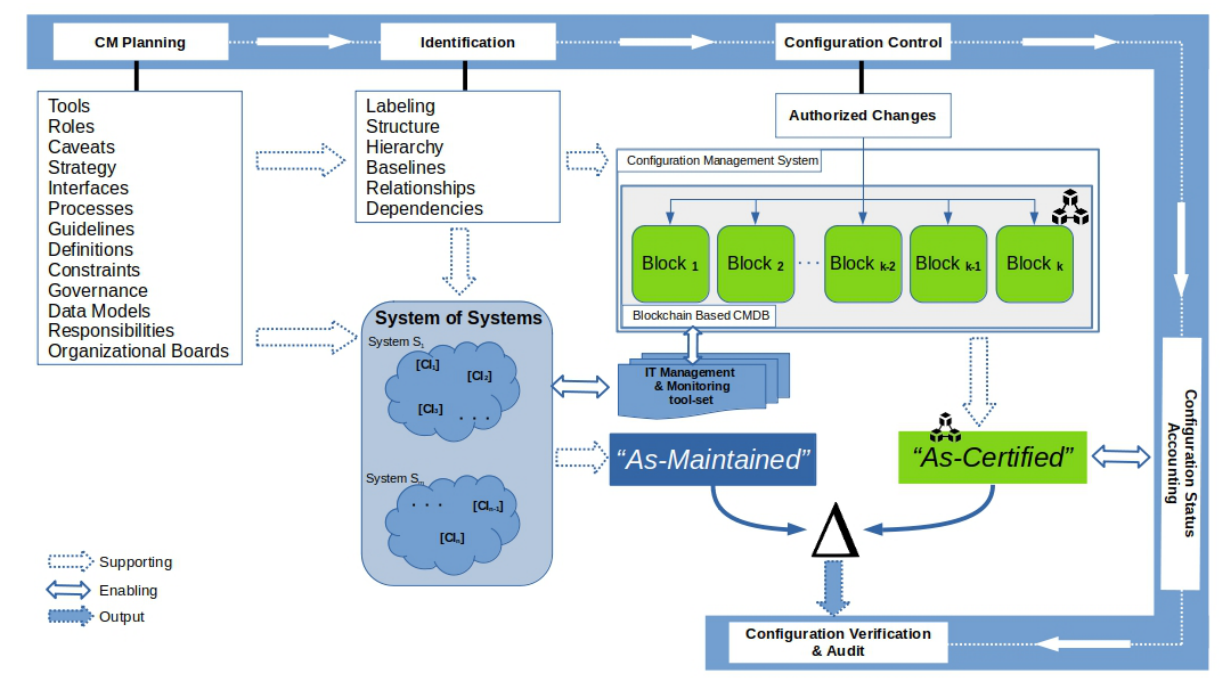
Figure 4. Configuration management